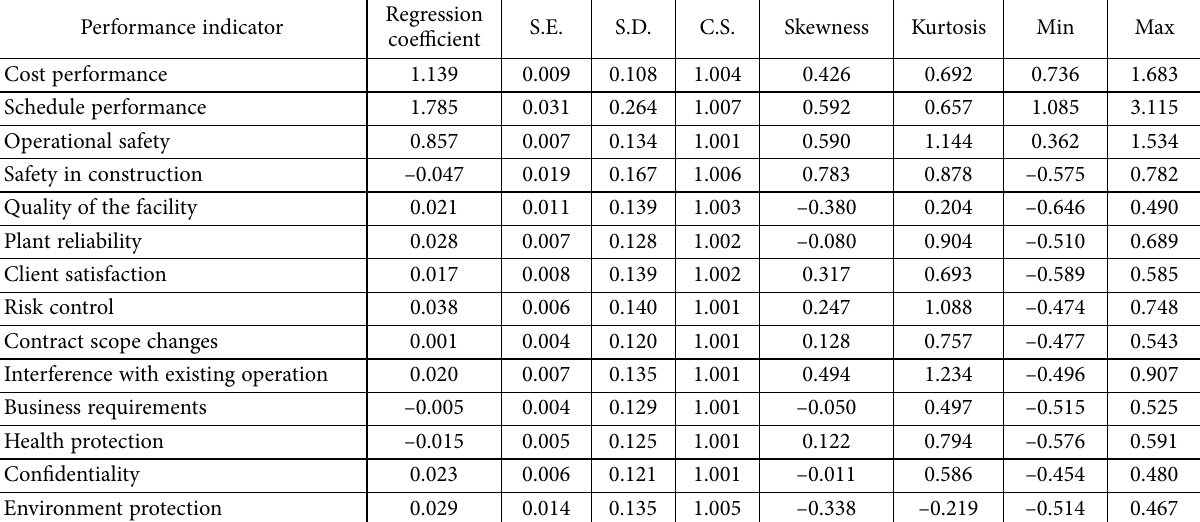
Table 5. Results of Bayesian